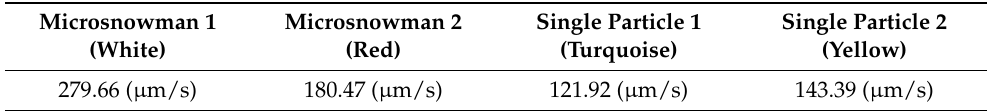
Table 2. Calculated Mean Velocities for Swarm Motion.